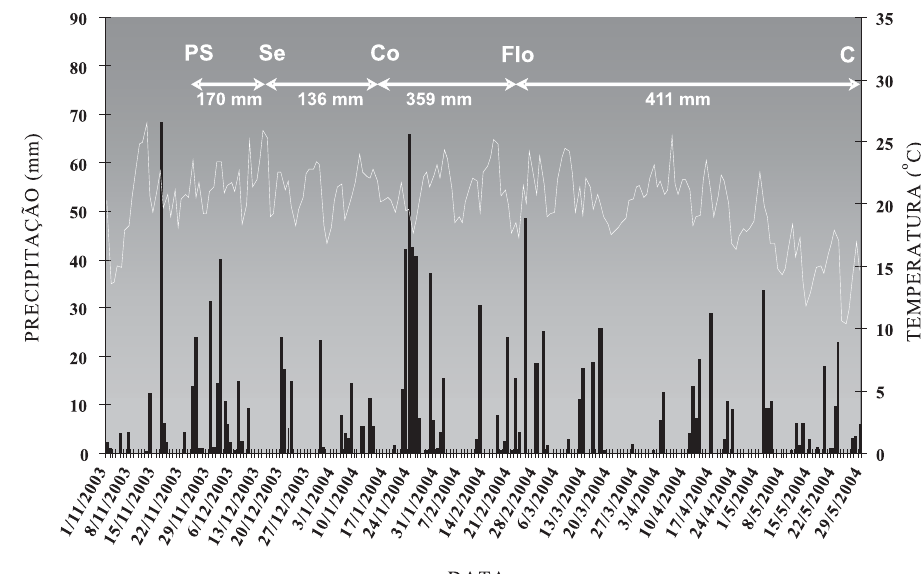
Figura 1. Temperatura média e precipitação pluvial durante o período de condução do